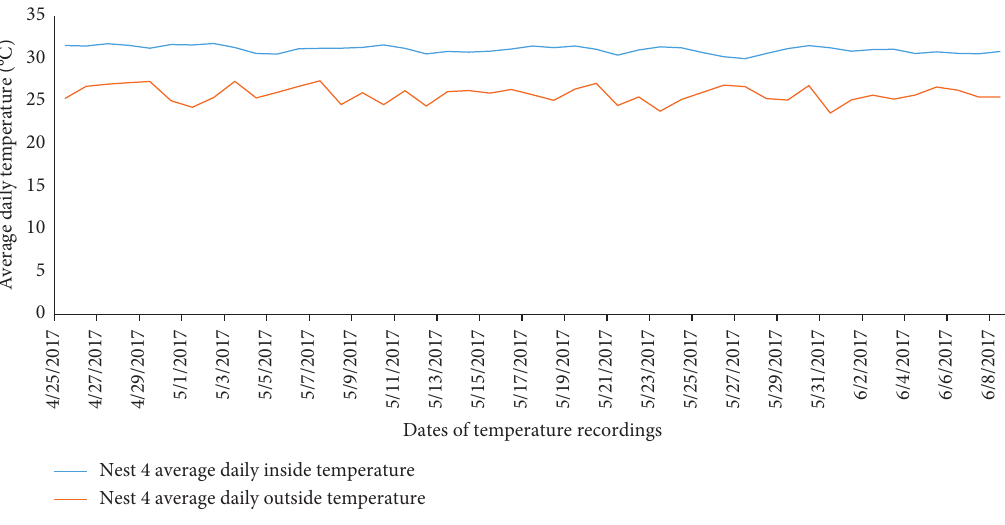
Figure 6: Variation trend of nest 4 ambient temperature and the incubation temperature. Table 3: Fecundity parameters of West African dwarf crocodiles in the Chirehin Community Land, Ghana. SD represents standard deviations and N the total number of recordings used for the analyses,